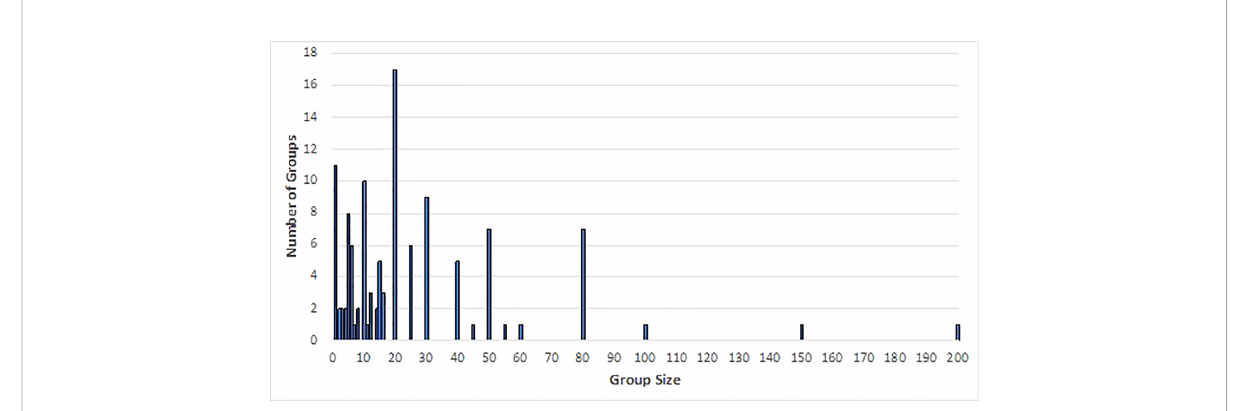
FIGURE 2 Group sizes of free-swimming false killer whale groups sighted 2005 to 2021 (based on all data